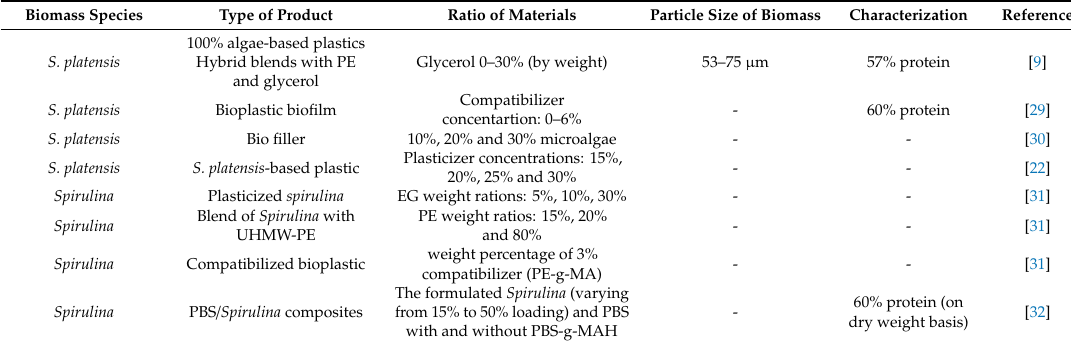
Table 3. Summary of conducted studies: Spirulina and S. plantensis .